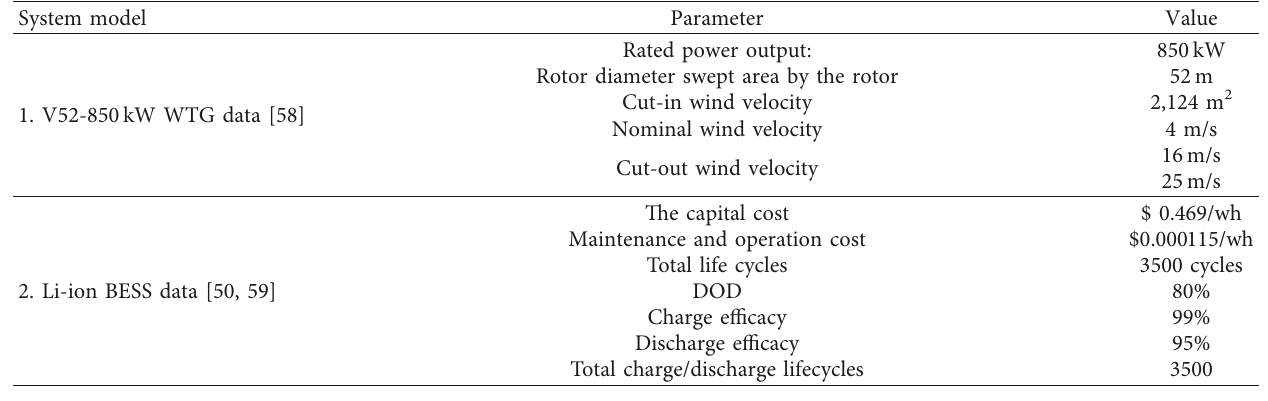
Table 3: System parameters.